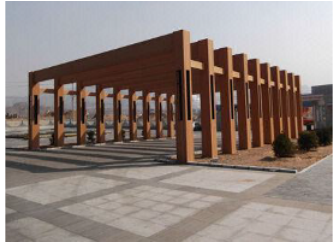
Fig. 4. Wood-plastic composite plank road.